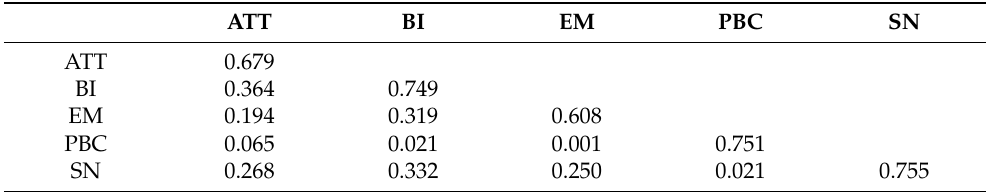
Table 4. Discriminant validity